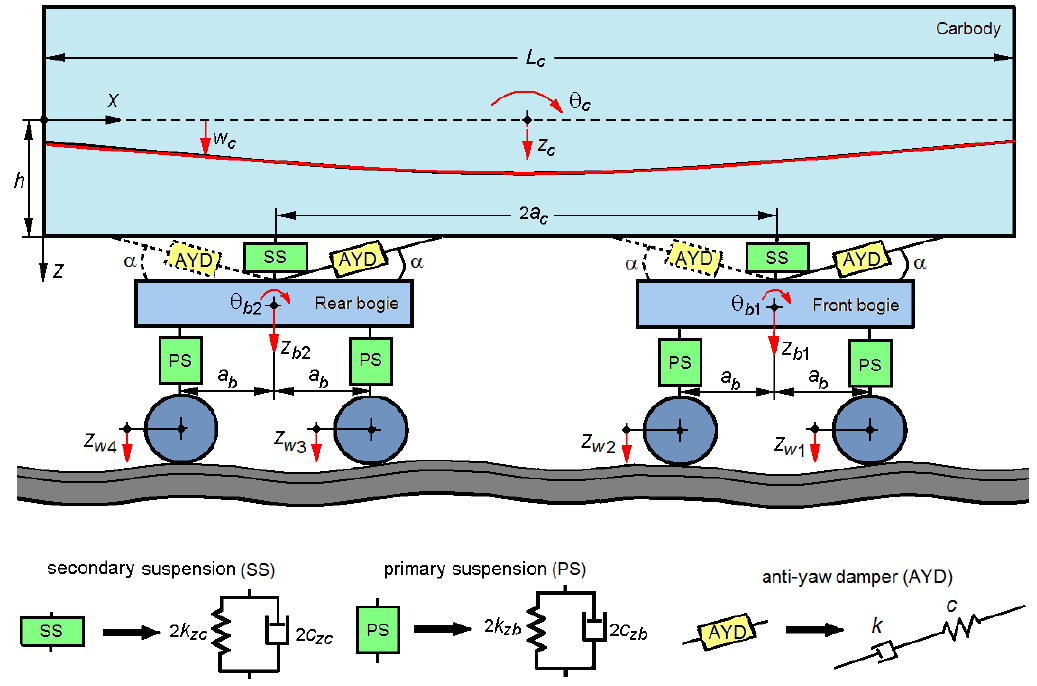
Figure 1. The mechanical model of the railway vehicle.